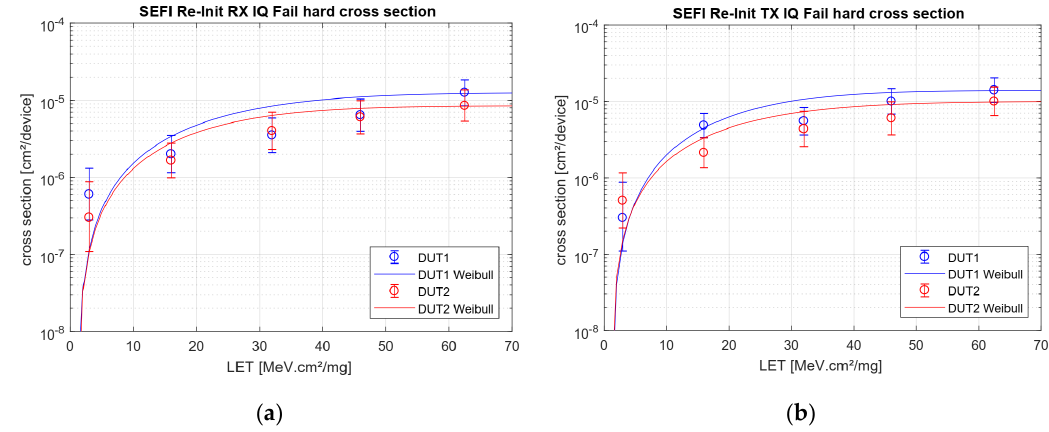
Figure 10. SEFI cross sections for ( a ) re-configuration and ( b ) re-initialization events with their corresponding Weibull fitting curve (W = 27.15, S = 1.44).